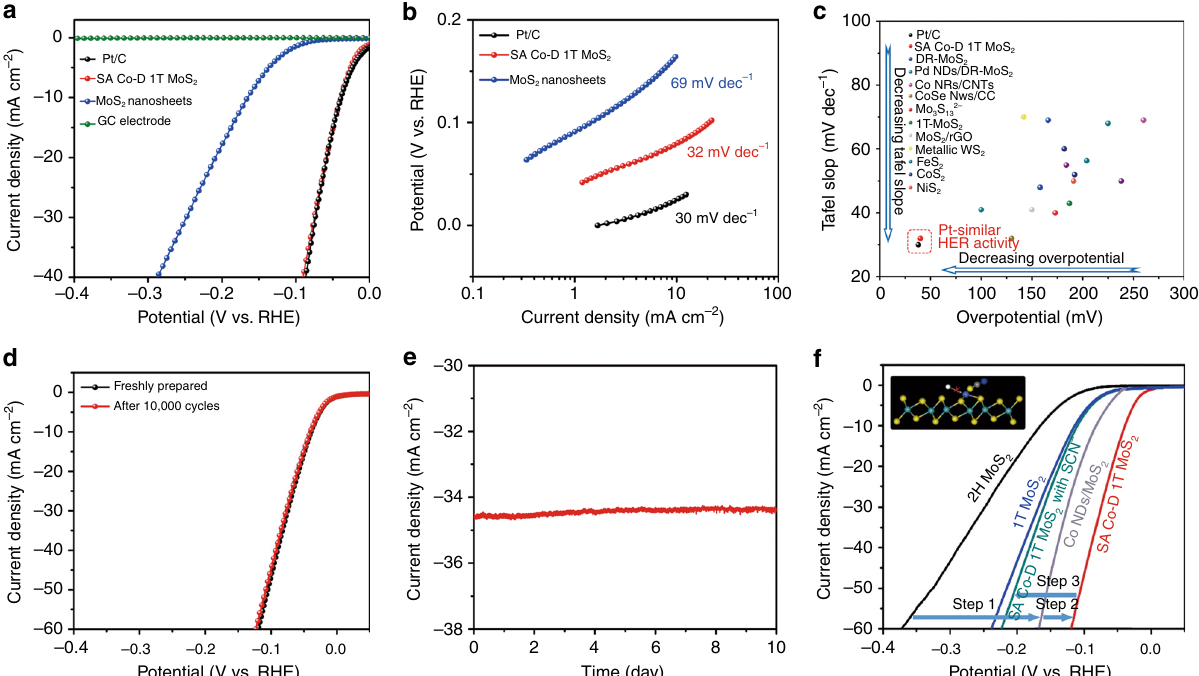
Fig. 3 HER performance of SA Co-D 1T MoS 2 . a Polarization curves of different catalysts tested in Ar-saturated 0.5 M H 2 SO 4 . b Tafel plots for the catalysts derived from a . c HER activity comparison using the Tafel slope (mV dec − 1 ) vs. overpotential at a current density of 10 mA cm − 2 . d Polarization curves of the SA Co-D 1T MoS 2 after 10,000 CV cycles. e Time dependence of the current density for SA Co-D 1T MoS 2 at a static overpotential of 100 mV vs. RHE. f HER polarization plots of MoS 2 , 1T MoS 2 prepared by lithiation, Co NDs/MoS 2 and SA Co-D 1T MoS 2 without and with SCN − ions. The inset shows